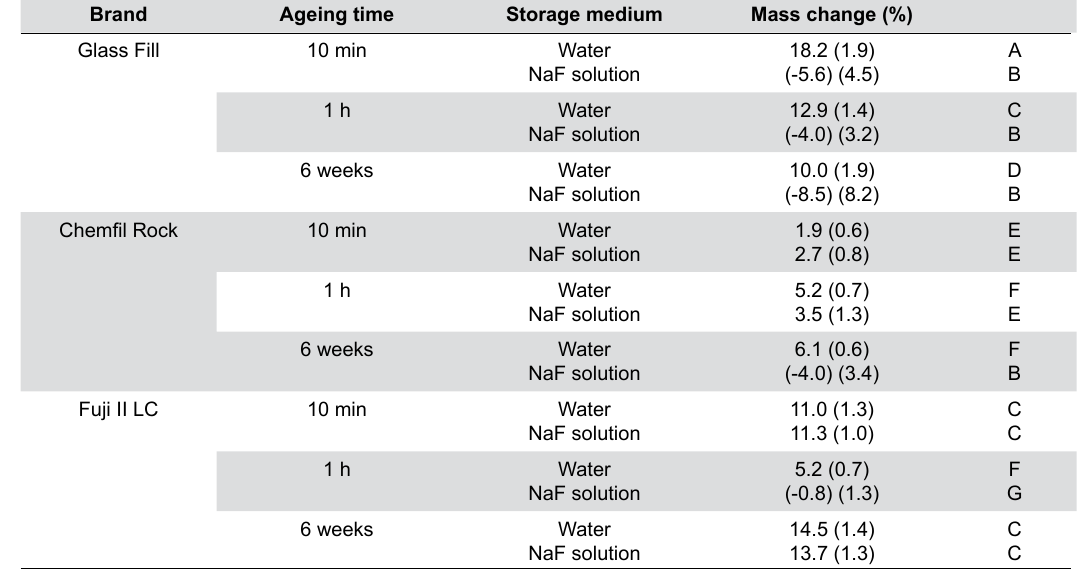
Table 1- Mass change on storage in water and NaF solution (groups that do not differ significantly are indicated with the same letters)